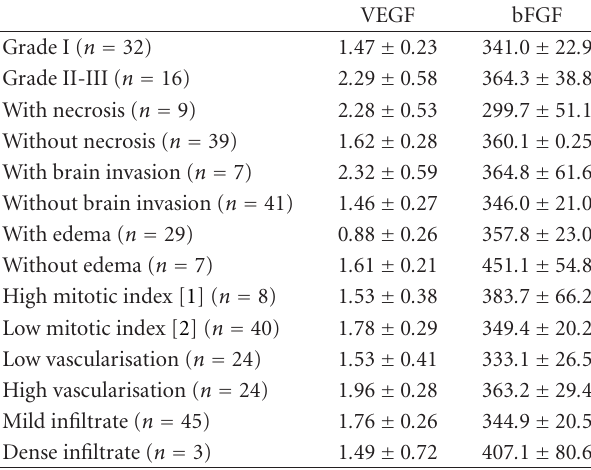
Table 1: VEGF and bFGF values in meningiomas. VEGF and bFGF levels are expressed as pg per µ g of protein. Results are reported as means ± SEM. n denotes the number of samples in each group [1]. Four or more mitoses per 10 high power fields [2]. Less than 4 mitoses per 10 high power fields. No statistical di ff erences were observed between groups (Mann-Whitney U